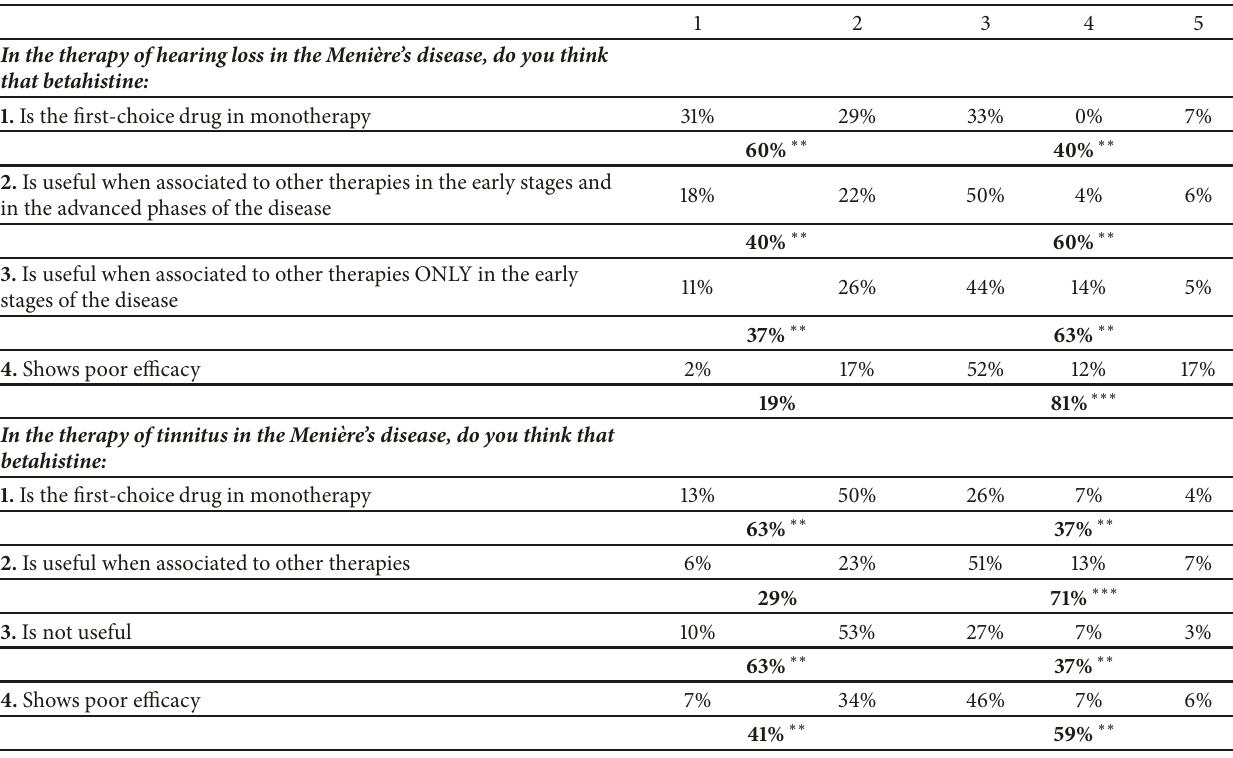
Table 3: Results of the Consensus Conference on the role of betahistine in the therapy of long lasting hearing loss, fullness and tinnitus. 1 = absolutely disagree, 2 = disagree, 3 = agree, 4 = more than agree, and 5 = absolutely agree. Consensus was reached when the sum of items 1 and 2 or 3, 4, and 5 reached 66%. Same asterisk